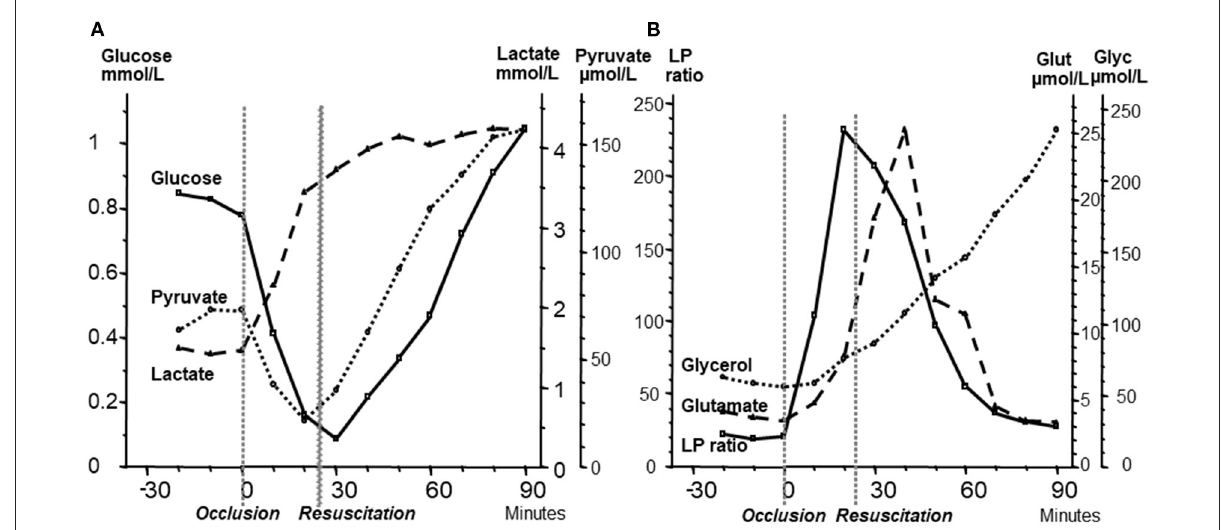
FIGURE5 (A): Changes in fetal intracerebral levels of glucose, pyruvate and lactate during cardiac arrest due to umbilical cord occlusion and after resuscitation. Umbilical occlusion and start of resuscitation are indicated in the figure. (B): Changes in intracerebral levels of lactate/pyruvate (LP) ratio, glutamate, and glycerol after umbilical cord occlusion and after resuscitation. Data (Mean levels) from (79).